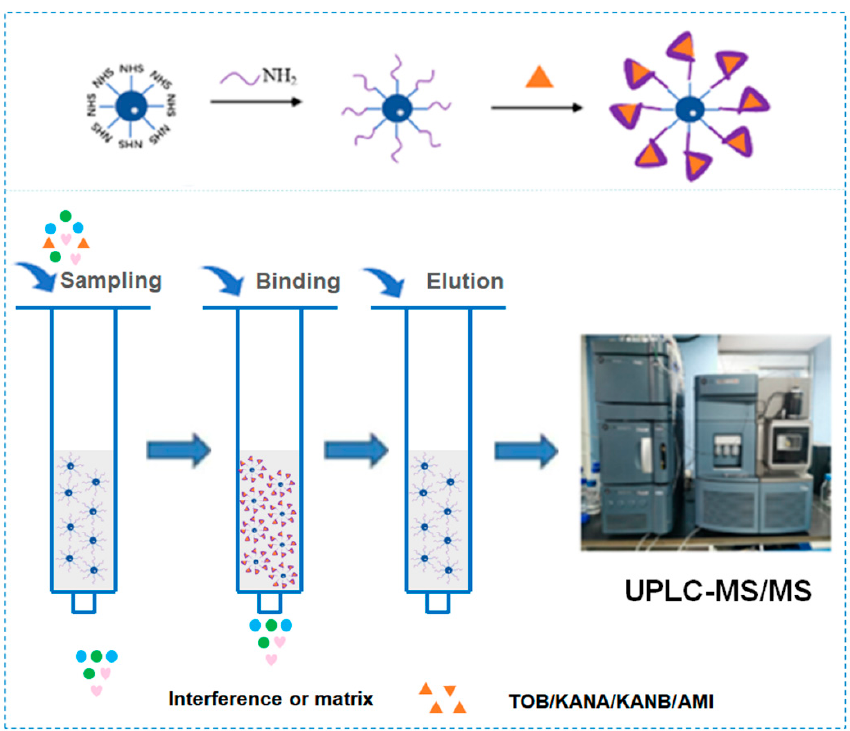
Figure 1. Schematic diagram of aptamer and agarose coupling and AAC working